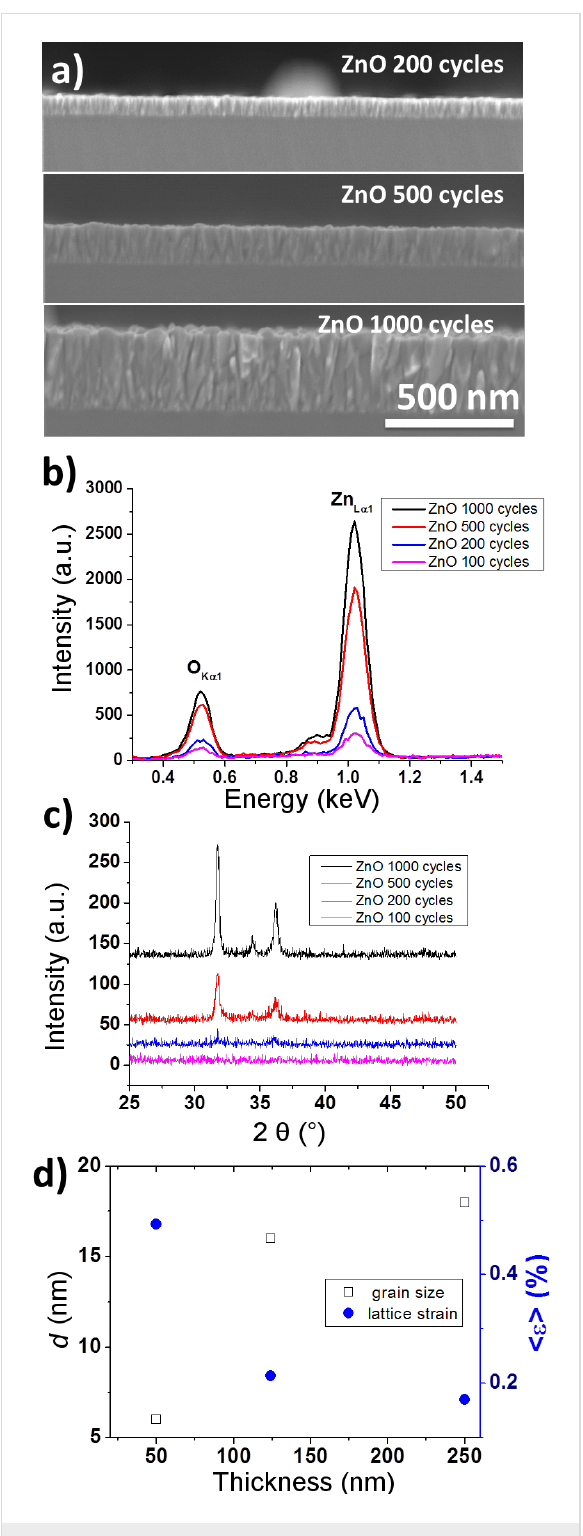
Figure 1: a) SEM images of a cross section of ZnO ALD films deposited on Si substrates by 200, 500, and 1000 cycles; b) EDX; c) GIXRD of ZnO ALD films deposited by 100, 200, 500, and 1000 cycles; d) grain size and lattice strain in ZnO ALD films of different